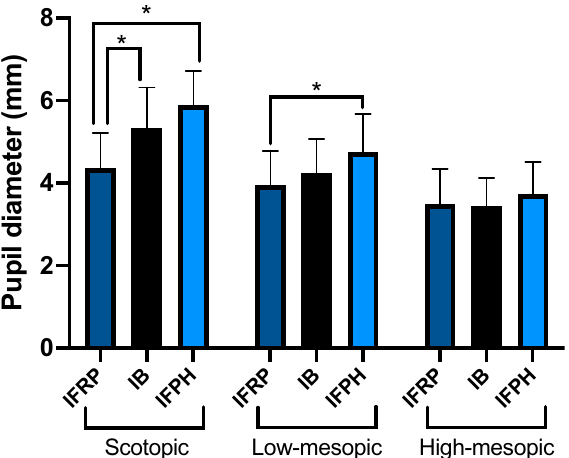
Figure 3. Comparison of pupil size 6 months after surgery at different levels of illumination for IFRP, IB and IFPH. Under high-mesopic lighting, no difference in pupil diameter occurred. IFRP showed a decreased pupil diameter for low-mesopic and scotopic lighting. IFPH showed slightly greater pupil size compared to